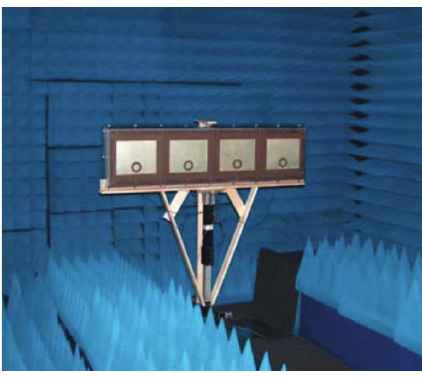
Figure 5: SAR-Low antenna mounted into the anechoic chamber at University of